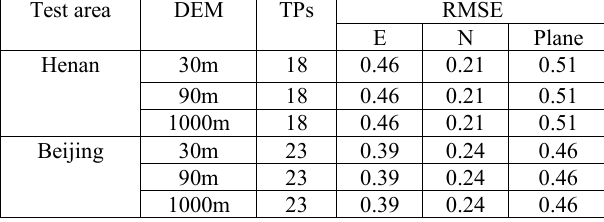
Table 3. Results of stitching with different